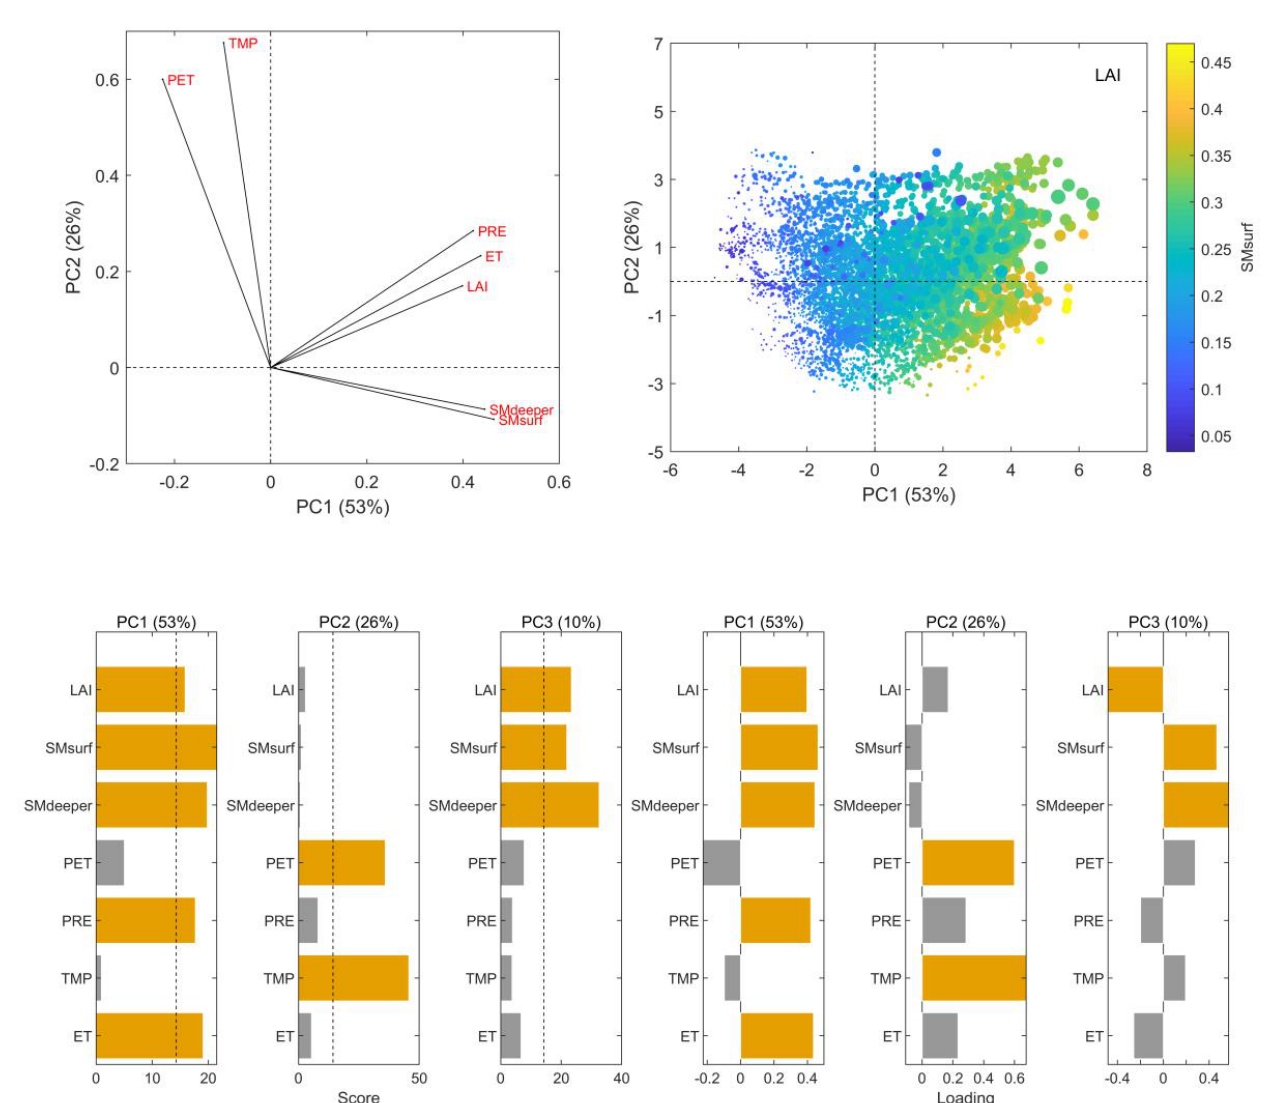
Figure 9. Relationship between the LAI and effect variables based on PCA.